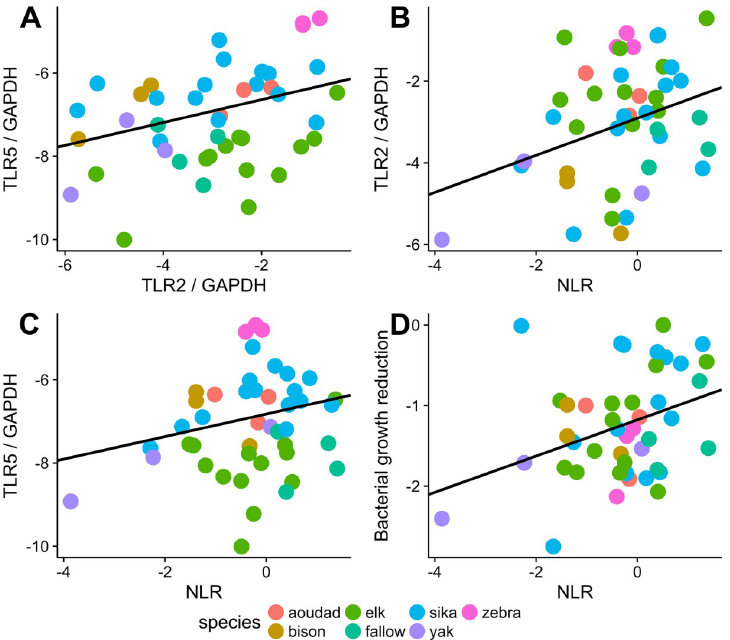
Fig 2. Measures of innate immunity were correlated in individual animals after accounting for species differences. Each data point represents an individual animal with log-transformed values and points color-coded by species. Correlations were found between neutrophil to lymphocyte ratio (NLR), toll-like receptors 2 and 5 (TLR2 and 5), and a plasma bacterial killing assay (BKA). BKA did not correlate with the TLRs. TLR2 and TLR5 were positively correlated (A, β = 0.744, SE = 0.216, p = 0.002, R S 2 = 0.287). Additionally, the NLR positively correlated with TLR2 (B, β = 0.249, SE = 0.105, p = 0.023, R S 2 = 0.113), TLR5 (C, β = 0.360, SE = 0.172, p = 0.044, R S 2 = 0.129), and BKA (D, β = 0.497, SE = 0.218, p = 0.029, R S 2 = 0.091).